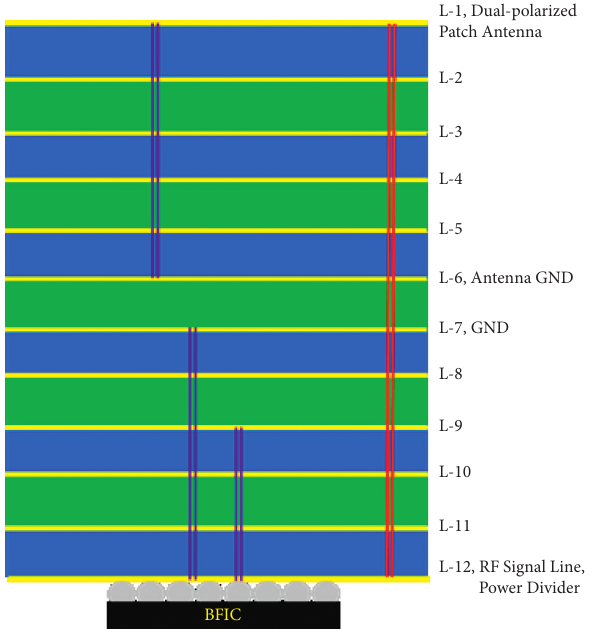
Figure 15: Simplified diagram of a low-cost PCB stack-up for 5G phased antenna arrays.